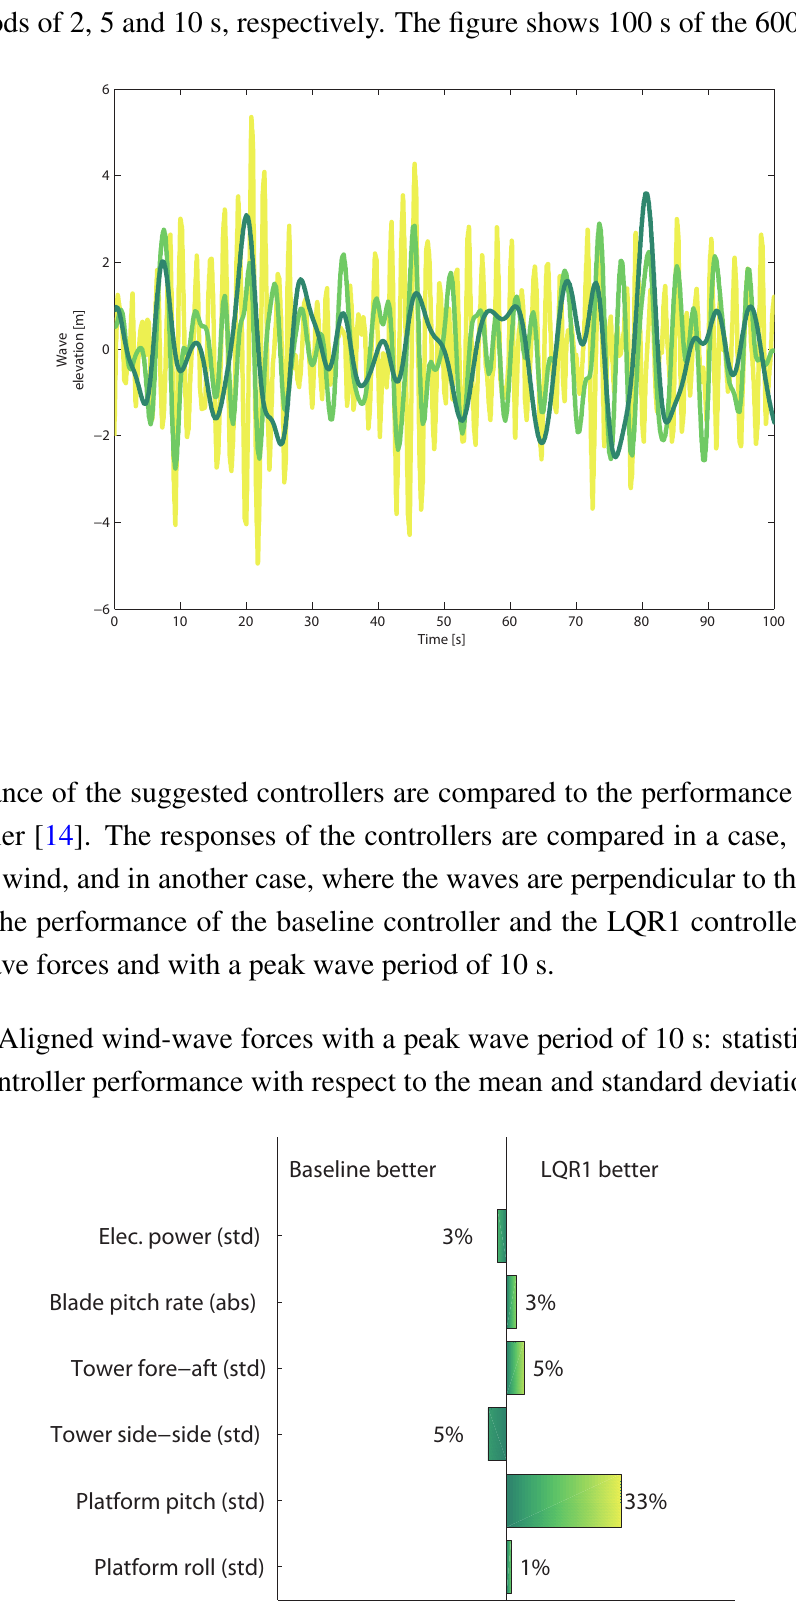
Figure 8. Wave height over time where yellow, light green and dark green represent peak wave periods of 2, 5 and 10 s, respectively. The figure shows 100 s of the 600 s sequences.